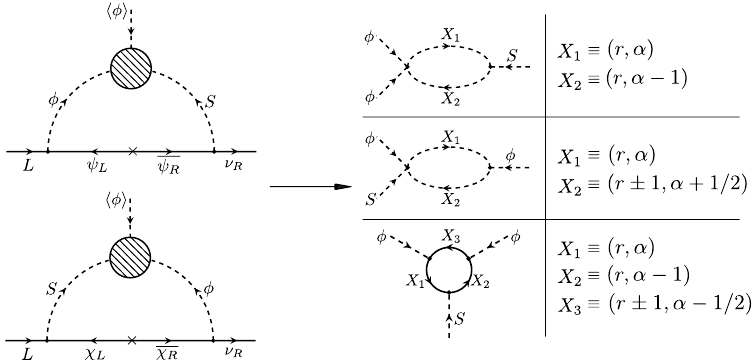
Figure 9 . Auxiliary diagrams corresponding to those of (cid:12)gure 6. The particle content depicted is the SM Higgs (cid:30) ( 2 ; 1 = 2), S ( 1 ; 1), ( 1 ; 1), (cid:31) ( 2 ; 1 = 2) with charges under L=R (cid:17) L=R (cid:17) (cid:17) (cid:17) (cid:0) (cid:0) SU(2) L U(1) Y , while the unknown (cid:12)elds X if solid lines, can be either scalars or fermions. (cid:2)